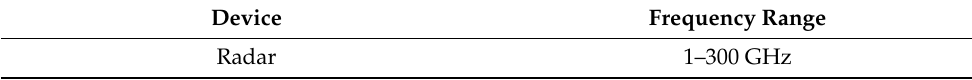
Table 3. Localization/surveillance devices and relative frequency